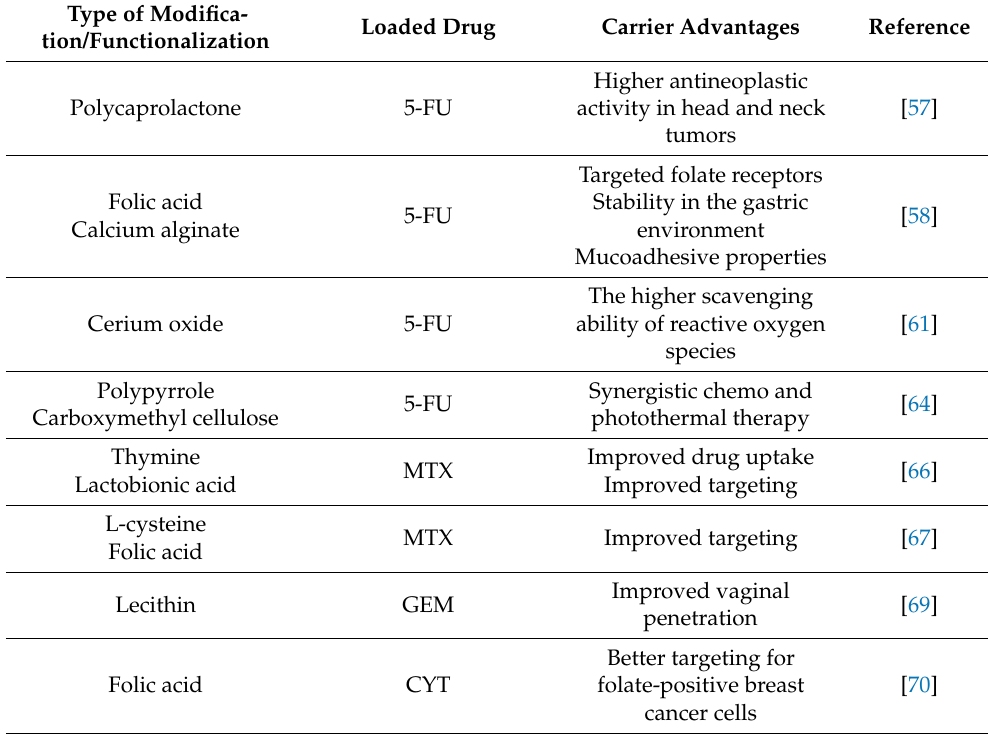
Table 3. Examples of CS-based nanoparticles for effective targeted delivery of